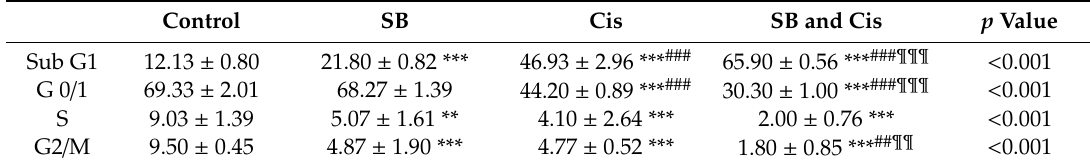
Table 3. Statistical analysis of PI positive staining detected by flow cytometry in GMSCs.